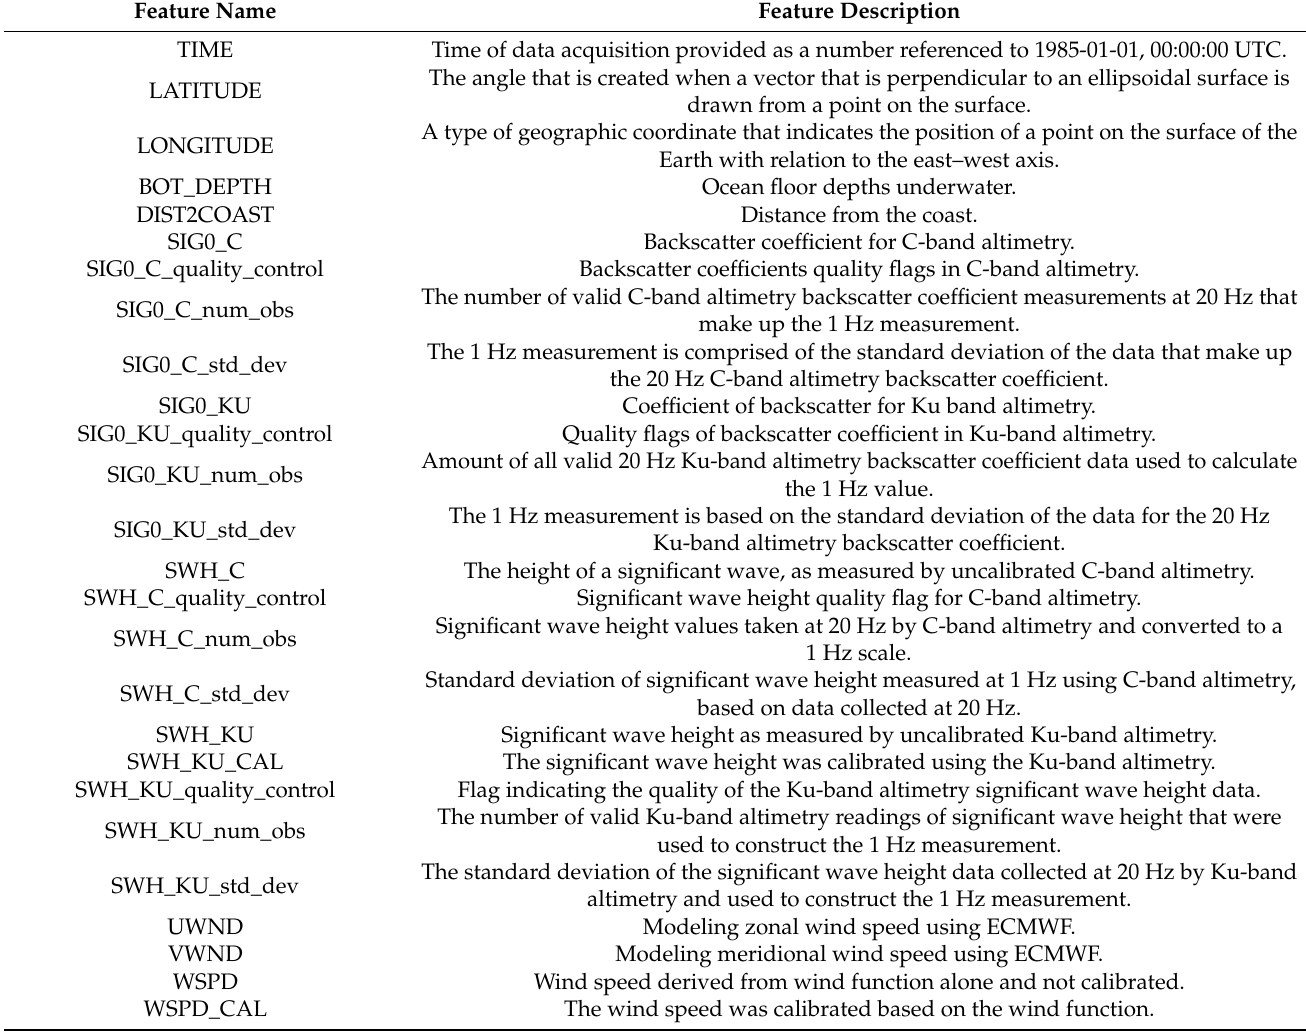
Table 2. Data variables’ names and their definitions